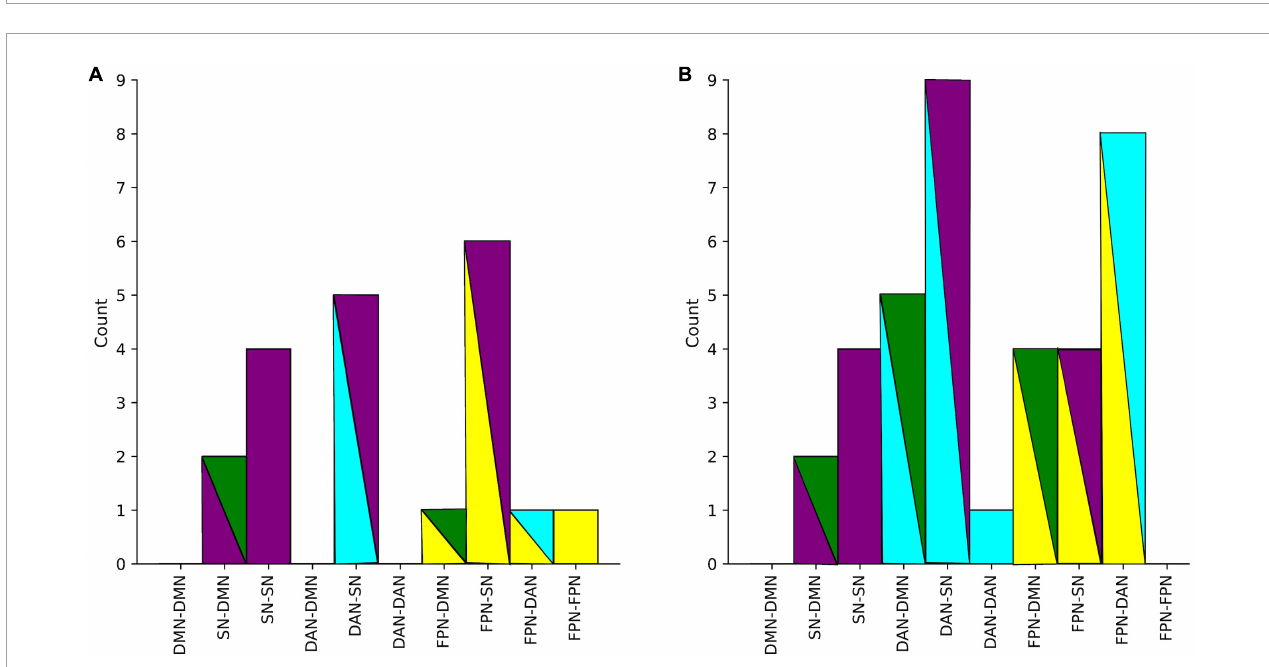
FIGURE5 (A) Number of all significant group differences in covariance between networks in the main sample. (B) Differences in covariance between networks in D+ sample (subjects with a psychiatric diagnosis). Colors represent networks: DMN–green, SN–purple, DAN–cyan,